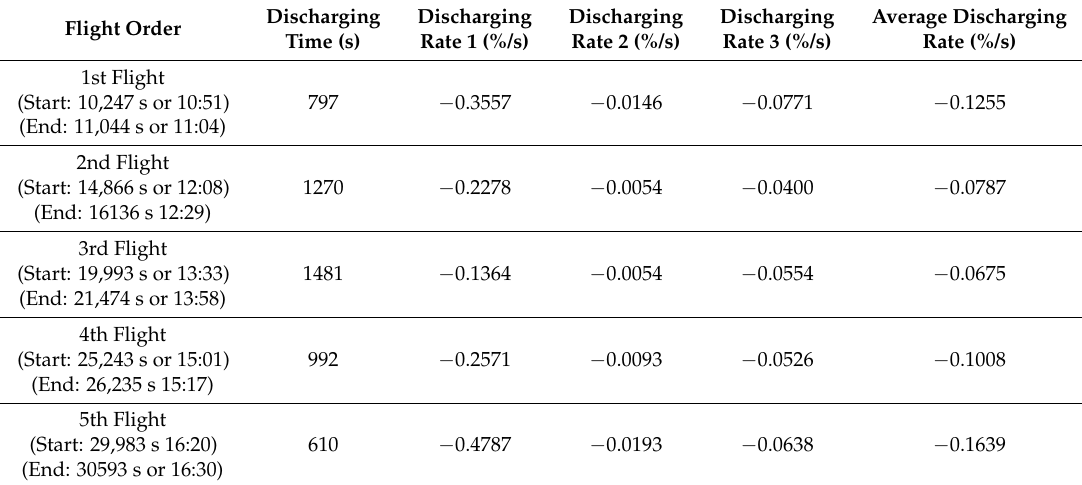
Table 7. Discharging progress time and rate of five flights.